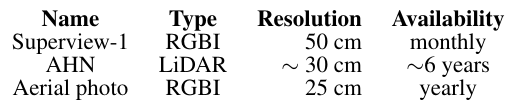
Table 1. Type, spatial resolution and availability of the data sets considered in this study.